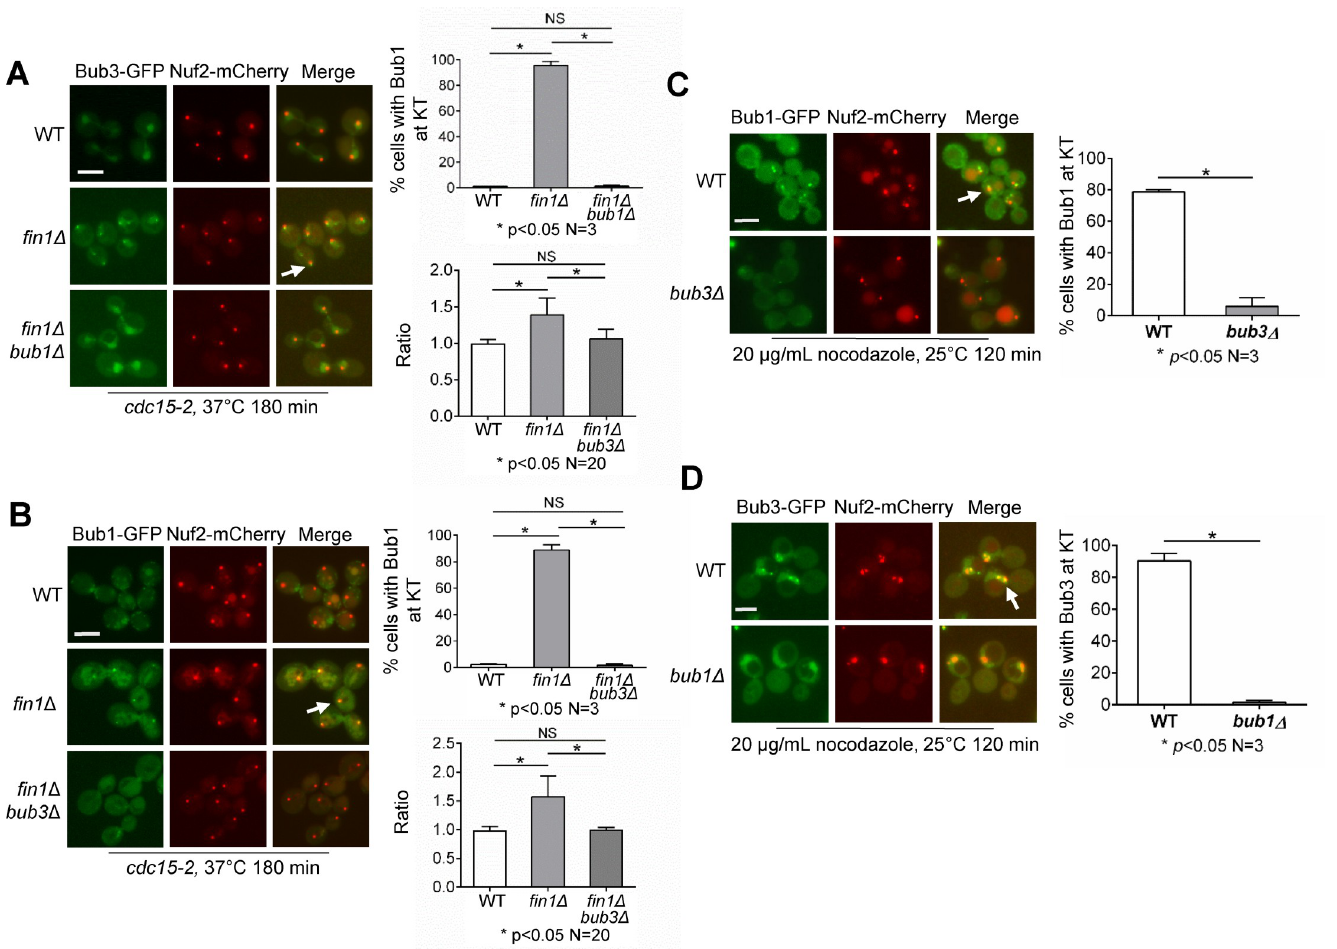
Fig 2. The kinetochore localization of Bub1 and Bub3 in anaphase is interdependent. (A) Bub3 shows kinetochore localization in fin1 Δ cells during anaphase and this localization depends on Bub1. WT (3888-11-2), fin1 Δ (3890-14-3), and fin1 Δ bub1 Δ (4065-4-3) cells in a cdc15-2 background containing Bub3-GFP and Nuf2-mCherry were grown to log-phase at 25˚C. The cells were then shifted to the non-permissive temperature of 37˚C for 180 minutes to allow inactivation of Cdc15. Samples were collected and pictures taken. The frequency of co-localization of Bub3-GFP and Nuf2-mCherry signals was counted for each strain (n = 100). White arrows indicate Bub3-kinetochore co-localization. The experiment was repeated three times and statistical significance determined by p < 0.05 using Kruskal-Wallis one-way ANOVA. Scale bar, 5 μ m. The ratio of Bub3-GFP intensity at the kinetochore over other nuclear regions was also measured using ImageJ (n = 20). The average ratio is shown in the bottom right panel. Statistical significance determined by p < 0.05 using Kruskal-Wallis one-way ANOVA. (B) The kinetochore localization of Bub1 in anaphase fin1 Δ cells depends on Bub3. WT (3177-3-4), fin1 Δ (3196-3-1), and fin1 Δ bub3 Δ (3905-6-1) cells in a cdc15-2 background containing Bub1-GFP and Nuf2-mCherry were grown as described above. The frequency of co-localization of Bub1-GFP and Nuf2-mCherry was counted for each strain (n = 100). White arrows indicate Bub1-kinetochore co-localization. The experiment was repeated three times and statistical significance was determined as described above. Scale bar, 5 μ m. The ratio of Bub1-GFP intensity at the kinetochore over other nuclear regions was also measured using ImageJ (n = 20). The average ratio is shown in the bottom right panel. Statistical significance determined by p < 0.05 using Kruskal-Wallis one-way ANOVA. (C) The kinetochore localization of Bub1 in nocodazole-treated cells depends on Bub3. WT (3887-4-1) and bub3 Δ (3887-3-4) cells with Bub1-GFP and Nuf2-mCherry were grown to log-phase at 25˚C. Nocodazole was added to the cell cultures to a final concentration of 20 μ g/mL. After incubation for 120 minutes, samples were collected and pictures taken. The experiment was repeated three times and statistical significance was determined. Scale bar, 5 μ m. (D) The kinetochore localization of Bub3 in nocodazole-treated cells depends on Bub1. WT (4065-8-1) and bub1 Δ (4065-3-1) cells with Bub3-GFP and Nuf2-mCherry were treated as in (C). The experiment was repeated three times and statistical significance determined by p < 0.05 using Wilcoxon rank sum test. Scale bar, 5 μ m. cells (S1A Fig). Only 5% of WT cells showed kinetochore Bub3 localization in anaphase, com- pared to 85% of fin1 Δ mutant cells (S1B Fig). Bub3 also showed dynamic kinetochore localiza- tion during anaphase as 39% frames of fin1 Δ cells during anaphase showed Bub3 kinetochore localization, compared to 2% for WT cells (S1C Fig). We recognize that the number of fin1 Δ cells showing Bub1 or Bub3 kinetochore localization when arrested with cdc15-2 is notably